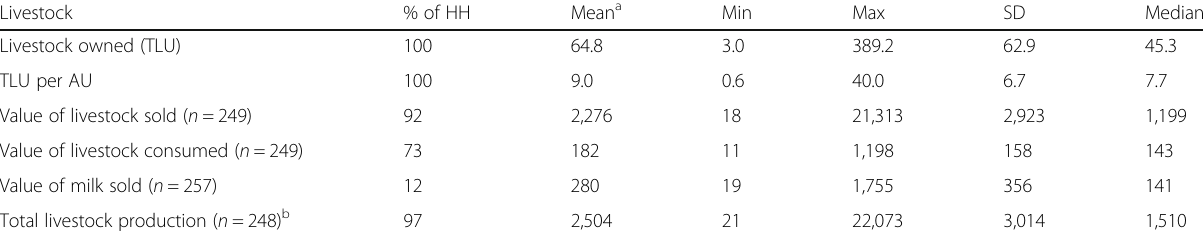
Table 4 Number of livestock owned and household annual incomes (US $ ) from different livestock production activities Livestock